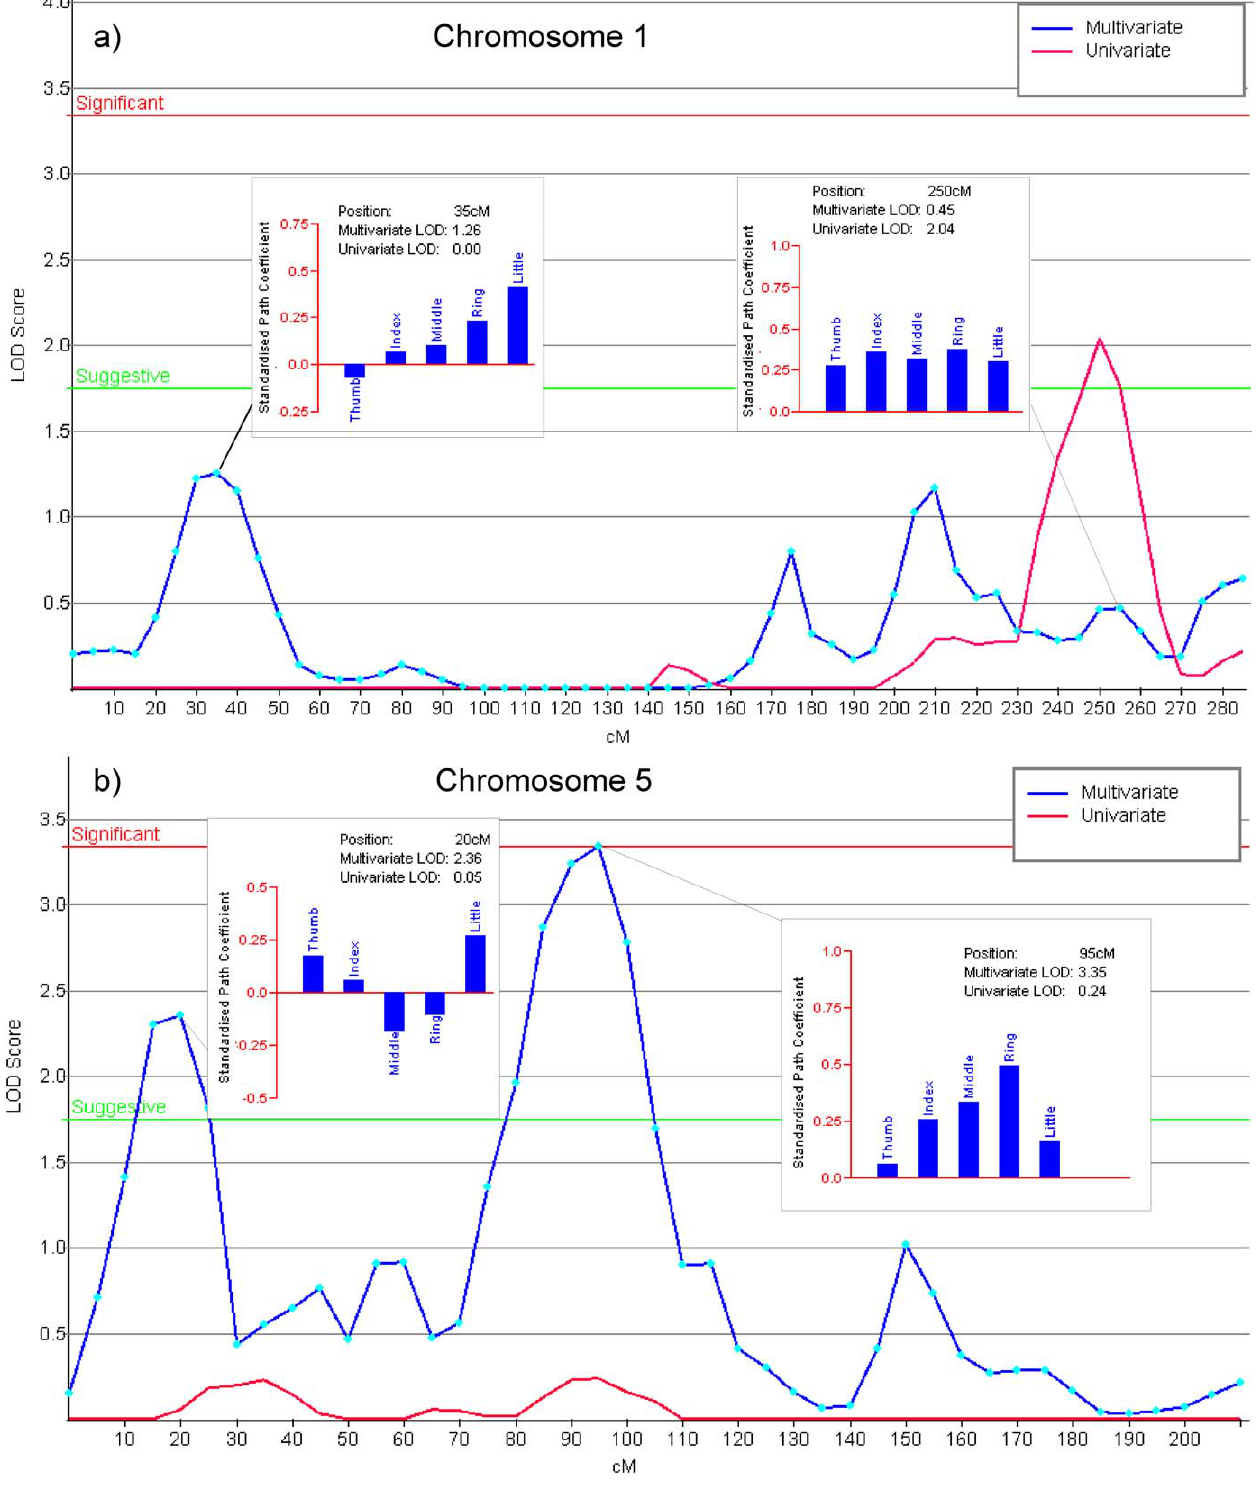
Figure 2. Results of Univariate (Red Line) and Multivariate (Blue Line) Linkage Analyses for Absolute Finger Ridge Count on Chromosomes 1 (A) and 5 (B). Empirical significant (thin red line) and suggestive (green line) thresholds for the univariate analysis obtained via simulation (1,000 replicates). Light blue dots indicate the 5-cM intervals at which linkage analyses were conducted. The inset graphs show the standardized path coefficients from the QTL factor from the multivariate analysis for each of the fingers. (Note: squaring the standardized path coefficients yields an estimate of the proportion of variance for each digit explained by the QTL.)